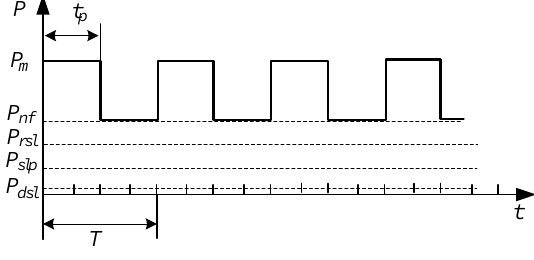
Figure 15. Power consumption corresponding to different working states.